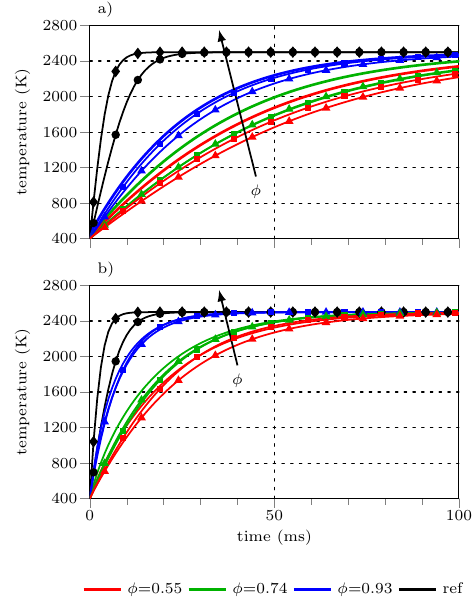
Figure 16. Comparison of resolved cluster mean temperatures ( ) and Lagrangian parcel tem- peratures using the multiple linear regression (MLR) ( ) and the Lévêque (GLE) ( ) Nusselt correlation for relative velocities of 0.5 m/s ( a ) and 13 m/s ( b ). Size equivalent ( ) and surface and mass equivalent ( ) reference cases use the Whitaker heat transfer